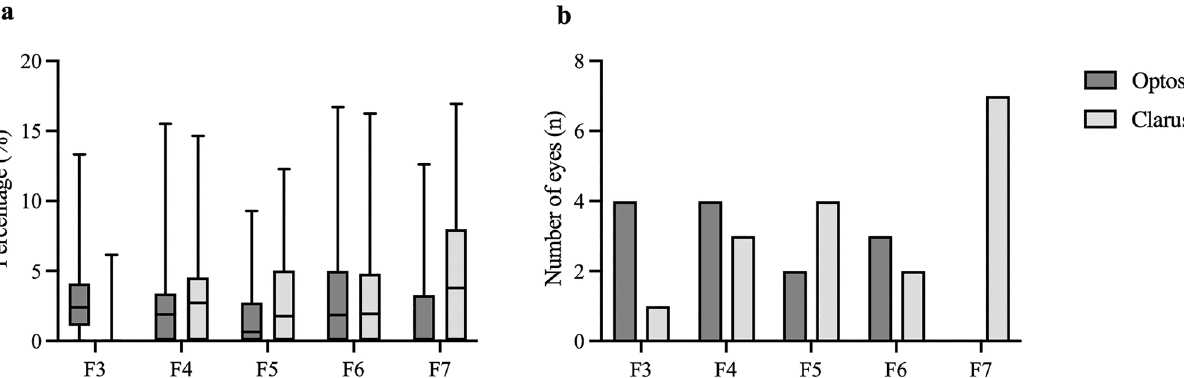
Figure 2. ( a ) The percentage of total gradable area (TGA) not seen on the other device in the peripheral fields F3–F7 evaluated via side-by-side comparison of images of the same eye acquired by both devices is visualized using box plots. The inferior boundary of the box indicates the 25th percentile, a black line within the box marks the median, and the superior boundary of the box indicates the 75th percentile. Whiskers extend to the smallest/ largest value within the interval [25th percentile − 1.5 × interquartile range; 75th percentile + 1.5 × interquartile range]. ( b ) Number of eyes with one or more than one hemorrhages detected in the area not seen on the other device in the peripheral fields